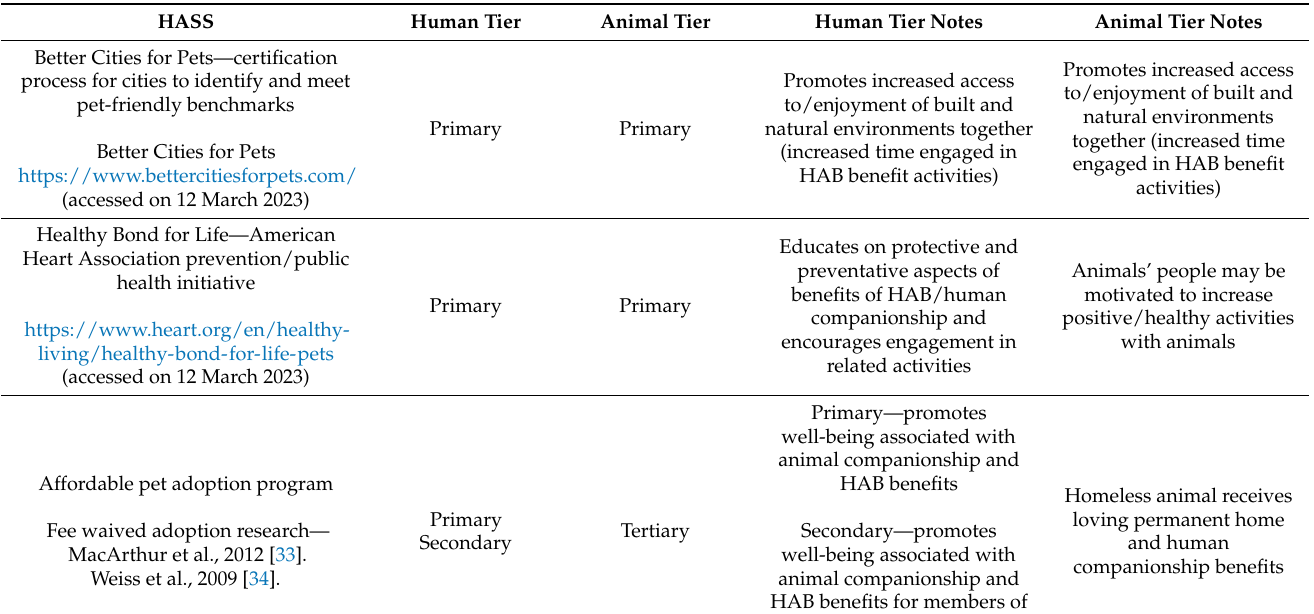
Table 1. Human–animal support services in a tiered public health